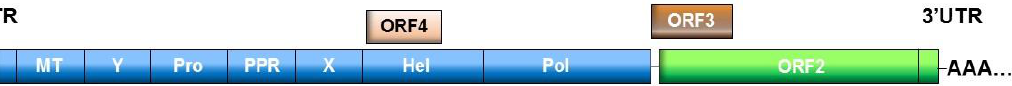
Figure 1. Organization of hepatitis E virus genome. ORF1 (dark blue box) encodes the nonstructural polyprotein. ORF4 has only been detected in HEV1. 7 mG: 7-methylguanosine cap; AAA…: polyadenylated tail; Hel: helicase; MT: methyltransferase; Pol: RNA polymerase; PPR: polyproline region, also called the hypervariable region; Pro: cysteine protease; UTR: untranslated region; X: X domain or macrodomain; Y: Y domain.